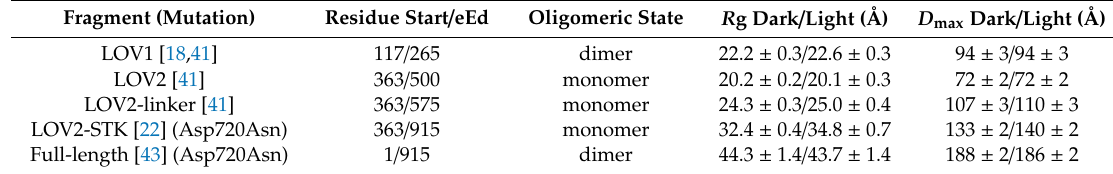
Table 1. Structural parameters of recombinant fragments and full-length of